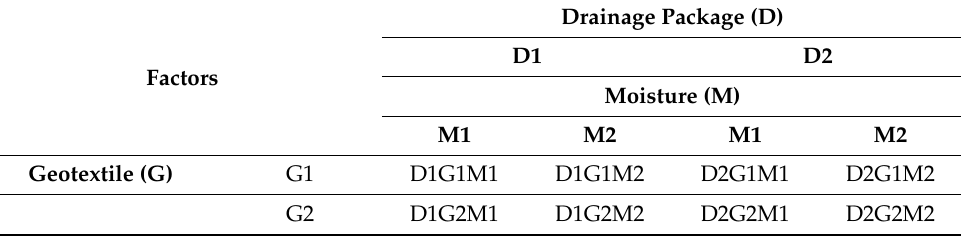
Table 1. Description of the 2 3 experimental designs. G1: Without geotextile, G2: with 2 kg/m 2 of geotextile; D1: without drainage package, D2: with drainage package; moisture: M1: Low gravimetric moisture content (11.16% ± 2.93 GMC), M2: High gravimetric moisture content (21.69% ± 3.90 GMC) or